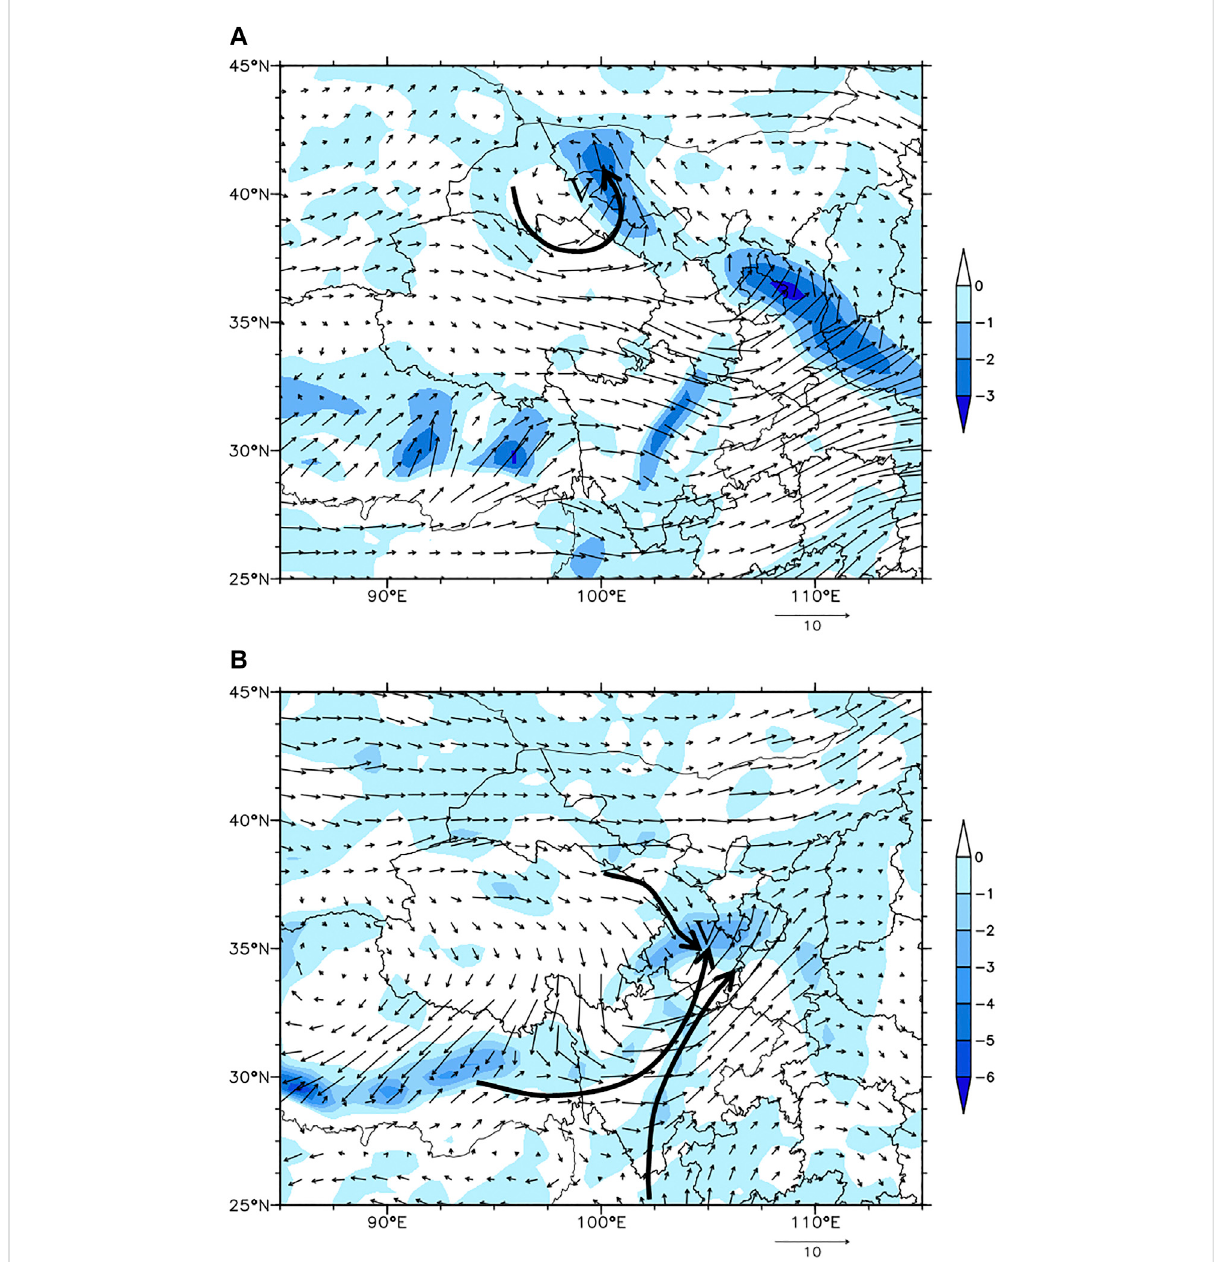
FIGURE 6 The water vapor fl ux divergence (shaded; Unit: 10 – 6 g cm − 2 · hPa − 1 s − 1 ) and water vapor fl ux (vectors; Unit: g · cm − 1 hPa − 1 s − 1 ) on 500 hPa at 06: 00 5 June 2012 (A) and at 12: 00 21 July 2013 (B) (the thick arrows denote water vapor transport path, V denotes the position of the vortex at the corresponding